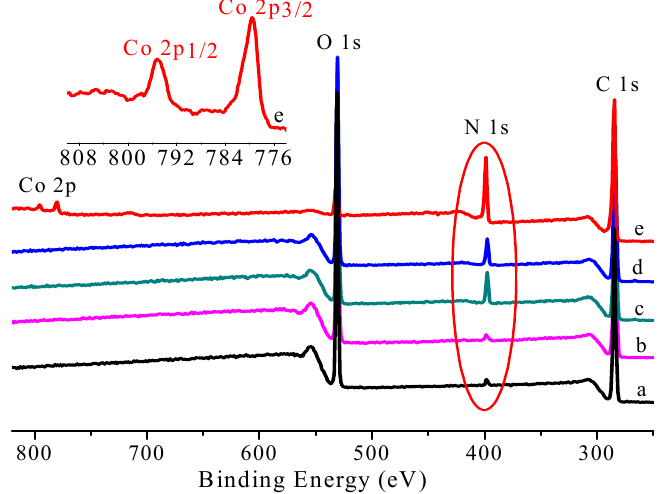
Figure 3. XPS spectra of (a): bacterial cellulose (BC); (b): oxidized BC; (c): tetraethylenepentamine (TP)-attached BC; (d): glutaraldehyde-activated BC and (e): CoPc@TP-BC. The window included shows, in detail, the Co region of CoPc@TP-BC. Table 1. Chemical compositions of BC during the functionalization processes.